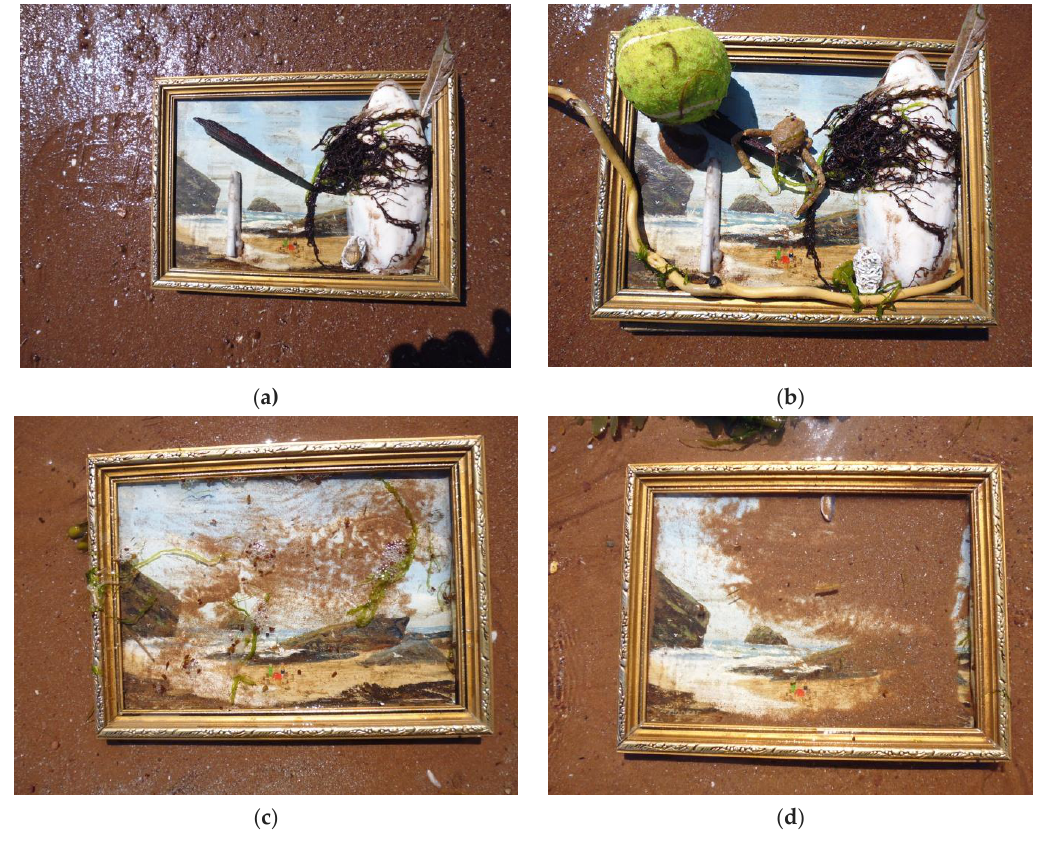
Figure 15. ( a ) First assemblage; ( b ) Second assemblage; ( c ) Waves wash assemblages away; ( d ) Waves wash sand over the painting.